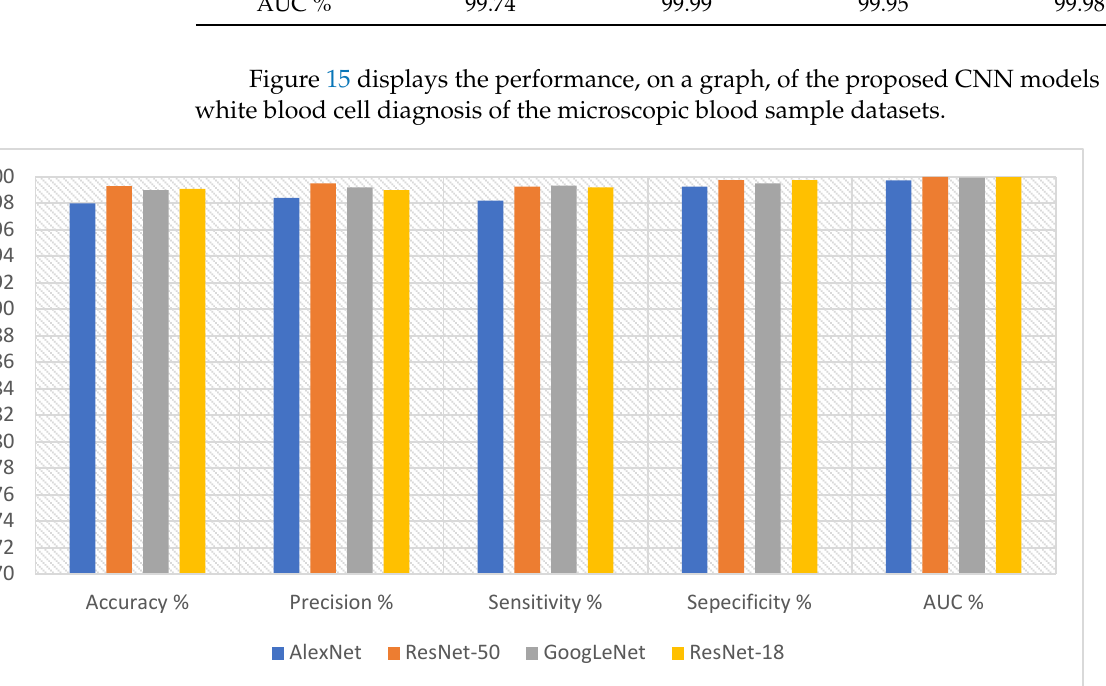
Figure 15. Display showing the performance of the CNN models.